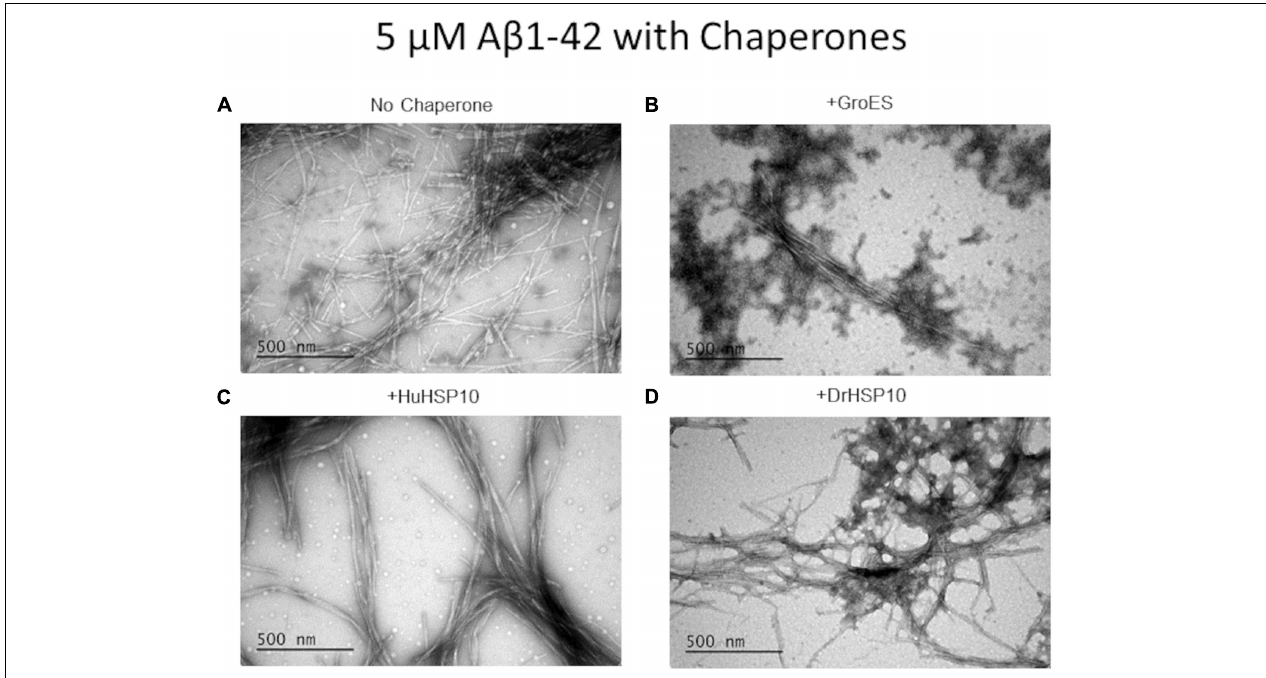
FIGURE 5 | Ultrastructure of A β 1–42 fibrils formed in the absence or presence of different HSP10 chaperones, imaged by transmission electron microscopy (TEM). (A) A β 1–42 no chaperone, (B) A β 1–42 + GroES, (C) A β 1–42 + HuHSP10, and (D) A β 1–42 + DrHSP10. Concentrations during fibrillation: A β 1–42, 5 µ M, chaperones 2.5 µ M. Presence of HSP10 appeared to promote multifilament bundled